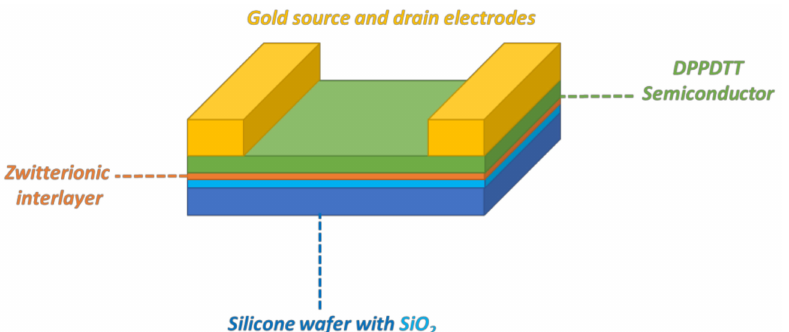
Figure 1. Scheme of an OFET with an Si gate electrode, SiO 2 insulating layer, BQMI zwitterionic layer, DPPDTT semiconducting film, Au source, and drain